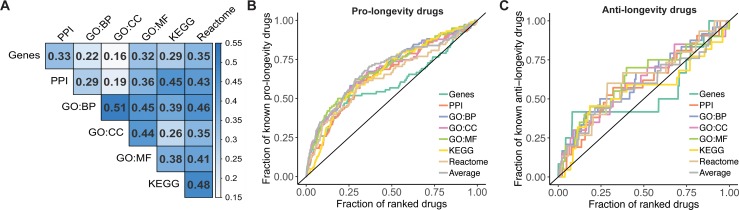
Comparison between the results using different data sources.A) Correlation between the ranked list of compounds. Boxes are coloured by the Kendall’s correlation coefficient. Enrichment curves for B) pro-longevity drugs and C) anti-longevity drugs. The results of each data source are displayed in lines with different colours. The enrichment expected by chance is shown as a diagonal line with AUC = 0.5.